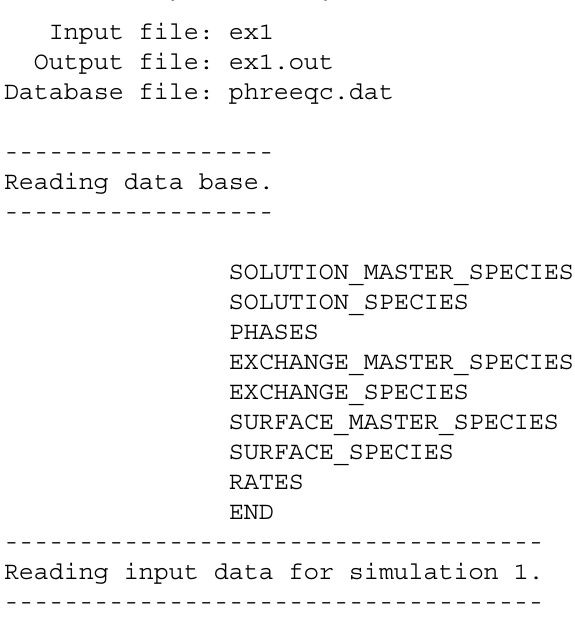
Table 11. Output for example